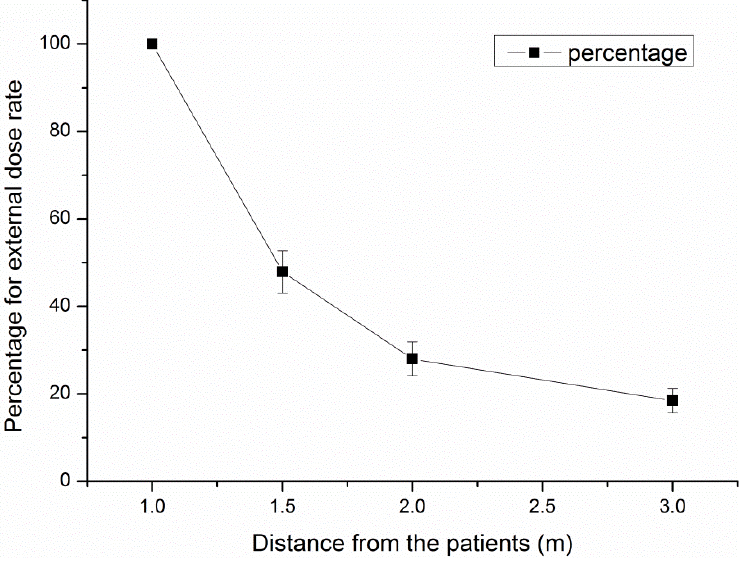
Figure 2. The percentage of external dose rate changes along with distance from the